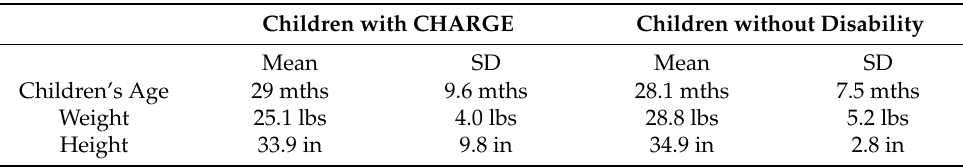
Table 1. Descriptive data of children with and without CHARGE syndrome.